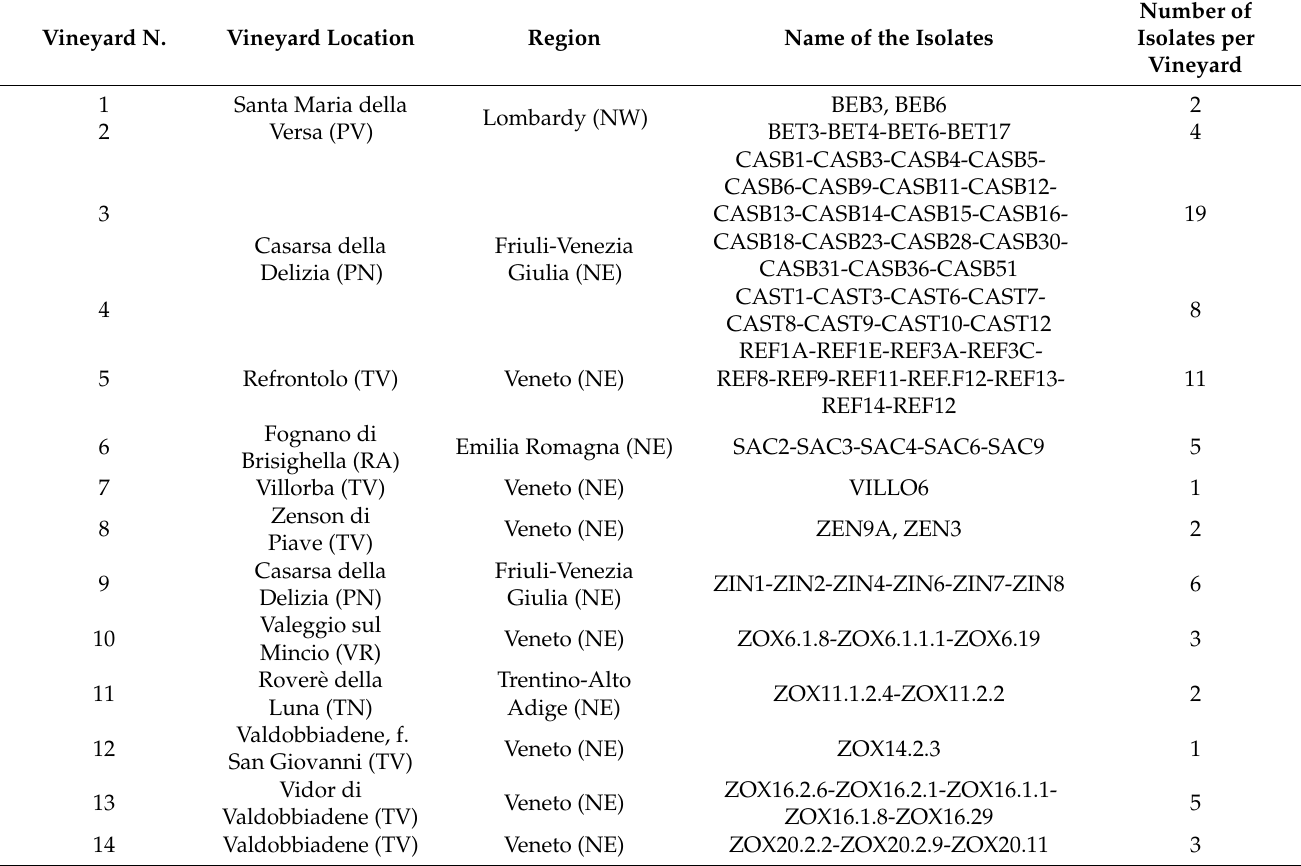
Table 6. Location of the vineyards and list of P. viticola isolates.